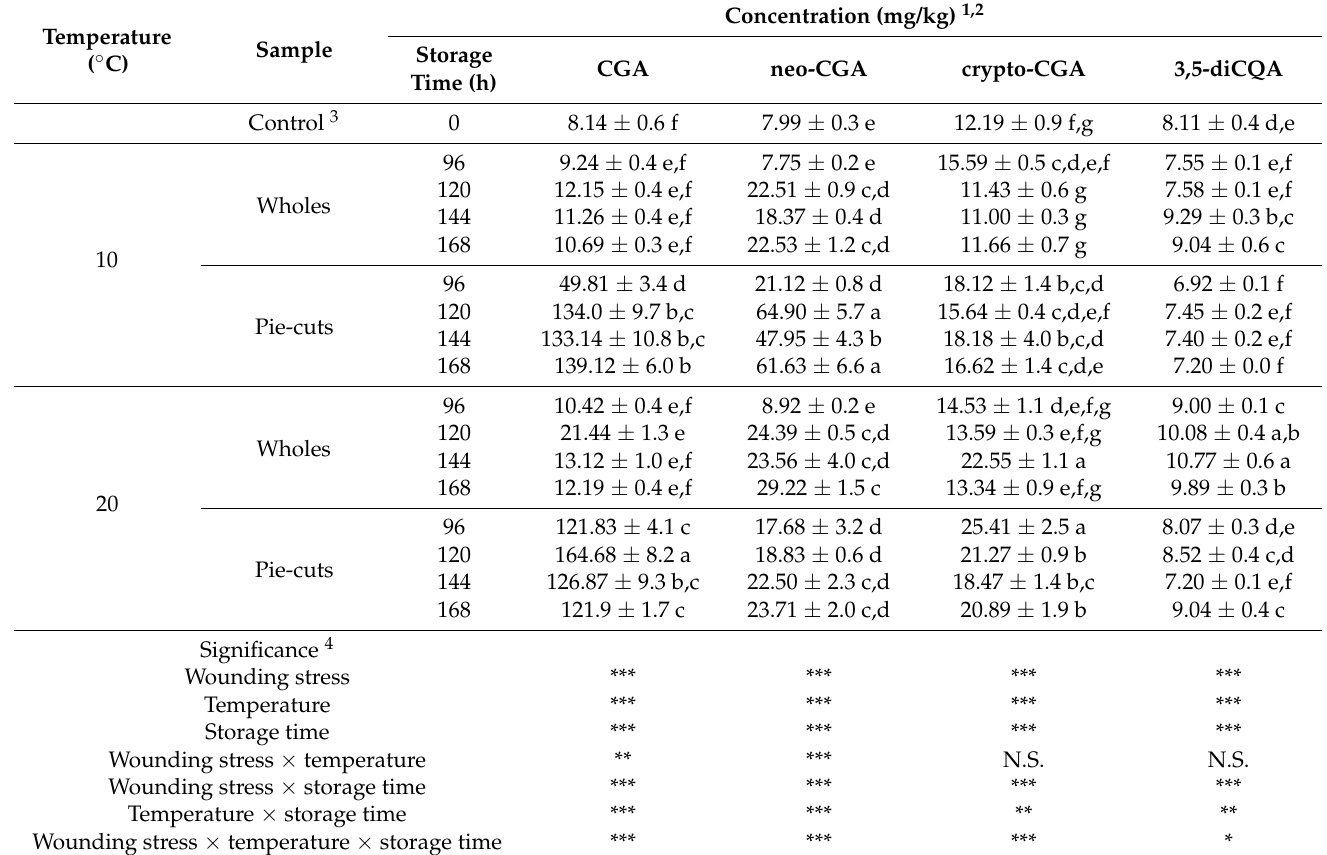
1 Data represent the mean of 5 repetitions ± standard error of the mean. 2 Different letters in the same column indicate statistical differences by the LSD test ( p < 0.05). 3 The control was whole potatoes before storage, and is referred in the text as the control before storage (CBS). 4 Asterisks indicate that main effects and interactions were significantly different by analyses of variance (ANOVA). N.S.—non significant, * p < 0.05, ** p < 0.01, *** p < 0.001. Abbreviations: CGA, chlorogenic acid; 3,5-diCQA, 3,5-dicaffeoylquinic